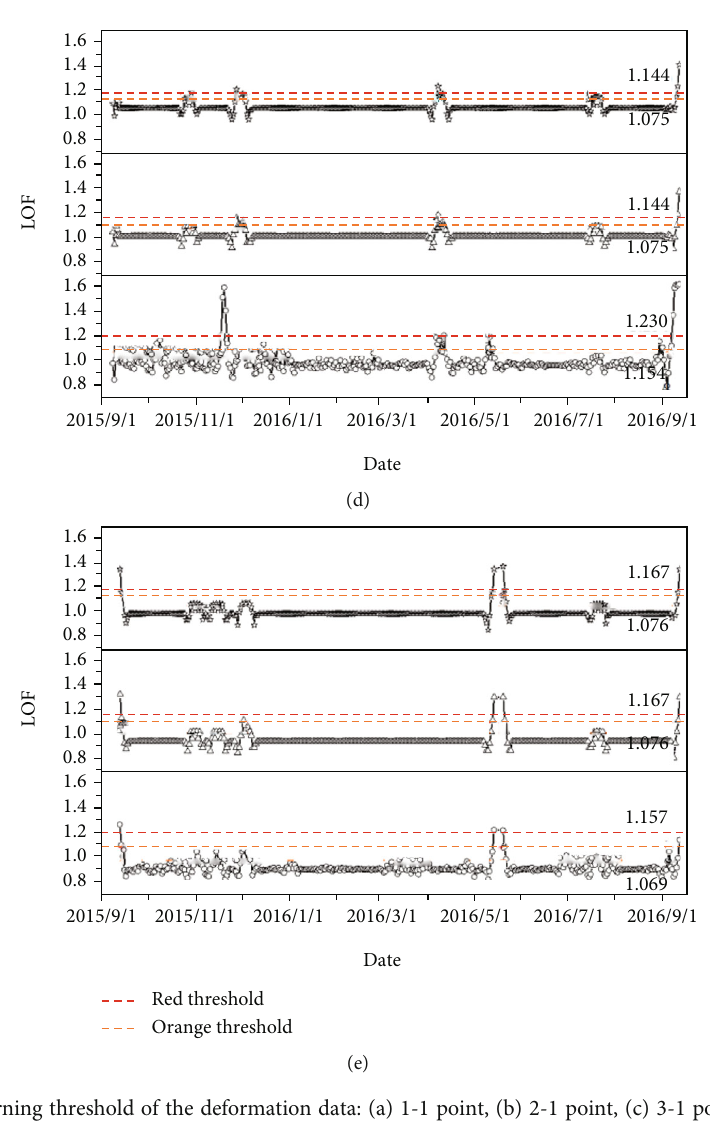
Figure 8: LOF value and warning threshold of the deformation data: (a) 1-1 point, (b) 2-1 point, (c) 3-1 point, (d) 3-2 point, and (e) 4-1 point.